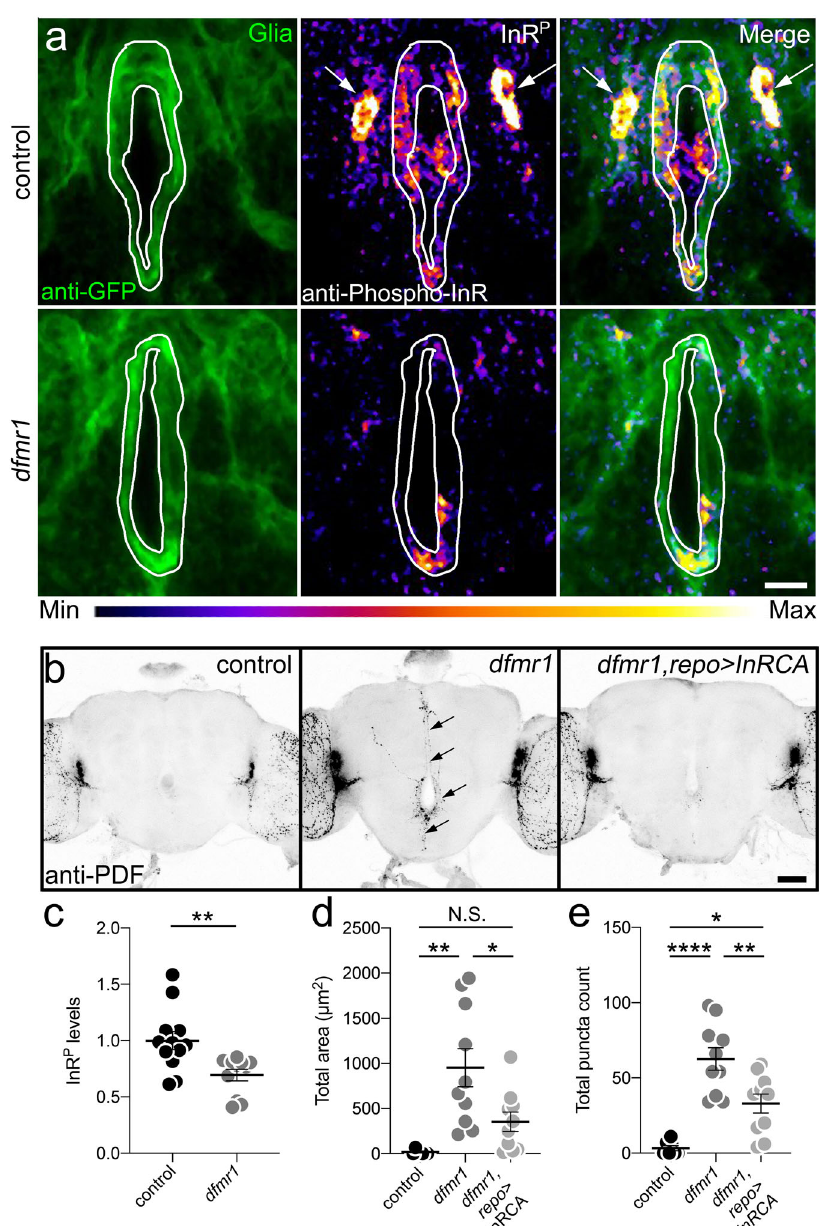
Fig. 9 FMRP drives glial insulin receptor activation to mediate PDF-Tri neuron clearance. a Central brains (2 DPE) co-labeled for glial mCD8::GFP (left), anti-phosphorylated insulin receptor (InR P , middle), and merge (right) in the control (UAS-mCD8::GFP/ + ; repo -Gal4/ + ) and dfmr1 null (UAS-mCD8:: GFP/ + ; dfmr1 50M , repo -Gal4/d fmr1 50M ). White outline indicates glial area used for InR P measurements; arrows indicate glial cell bodies. Range indicator bar for InR P intensity level below. Scale bar: 10 μ m. b Whole brains (5 DPE) anti-PDF labeled in glial driver control ( repo -Gal4/ + ), dfmr1 null with driver (dfmr1 50M , repo -Gal4/ dfmr1 50M ), and InRCA targeted to glia (UAS- InR del / + ; dfmr1 50M , repo -Gal4/ dfmr1 50M ). PDF-Tri neurons (arrows) in dfmr1 null. Scale bar: 50 μ m. c Quanti fi cation of normalized InR P levels from panel a . Two-sided t test, p = 0.0054, 1.00 ± 0.0815 n = 12 control, 0.694 ± 0.0521 n = 11 dfmr1 . d Quanti fi cation of the PDF-Tri area from panel b . ANOVA followed by Tukey ’ s multiple comparison test, p = 0.0011, 18.18 ± 9.959 n = 7 control, 952.3 ± 211.9 n = 10 dfmr1 ; p = 0.3183, 18.18 ± 9.858 n = 7 control, 352.8 ± 105.9 n = 10 InRCA; = 0.0197, 352.8 ± 105.9 n = 10 InRCA, 952.3 ± 211.9 n = 10 dfmr1 . e Quanti fi cation of PDF + puncta from panel b . ANOVA followed by Tukey ’ s multiple comparison test, p < 0.0001, 3.286 ± 1.686 n = 7 control, 62.6 ± 7.524 n